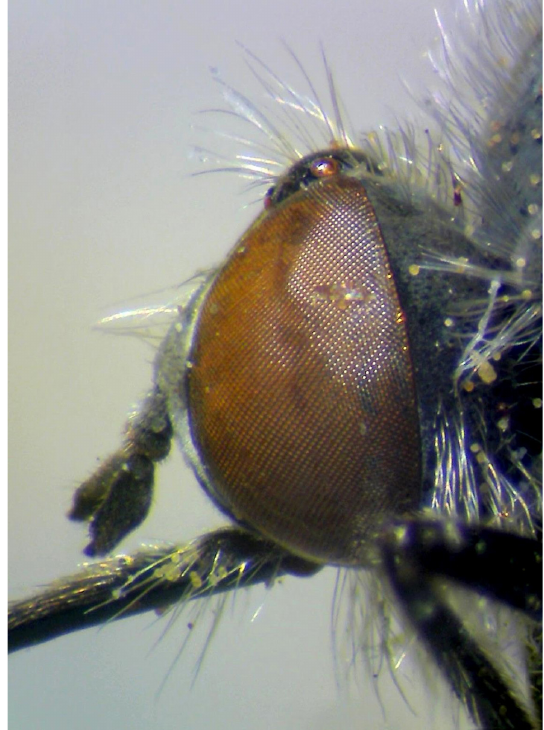
Fig. 18. Parusia aurata (Fabricius, 1794) gen. et comb. nov.,